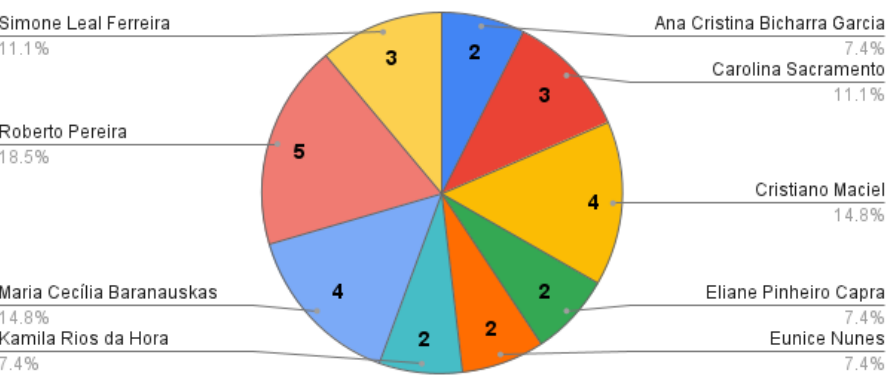
Figure 8. Research authors (with two or more occurrences.